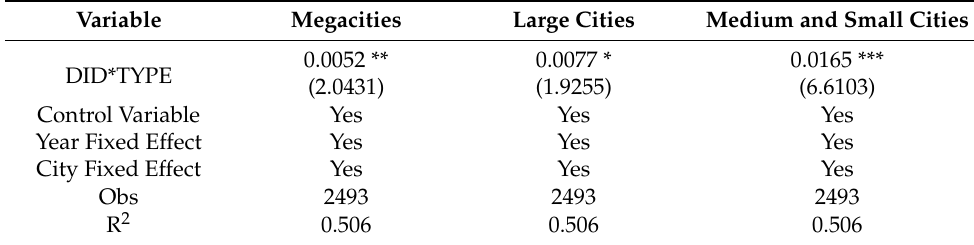
Table 6. Estimation results of city size